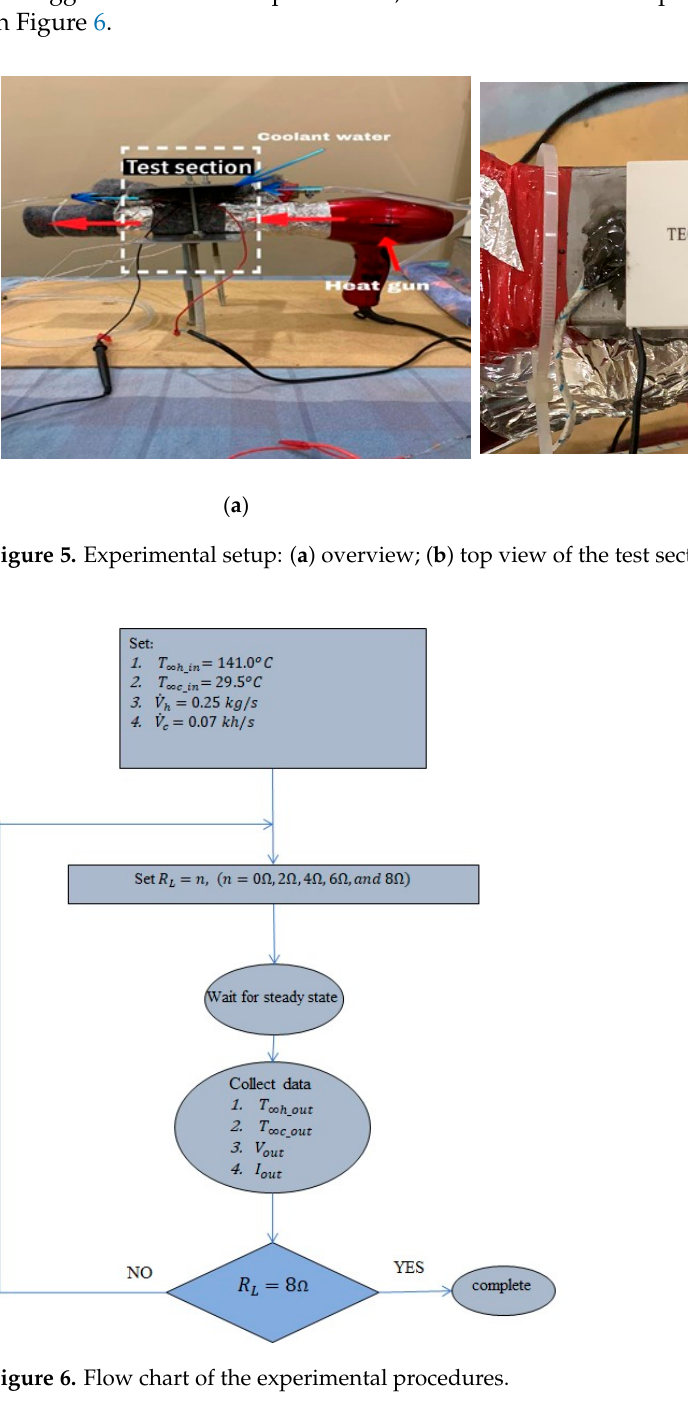
Figure 4. Schematic diagram of the experimental setup.